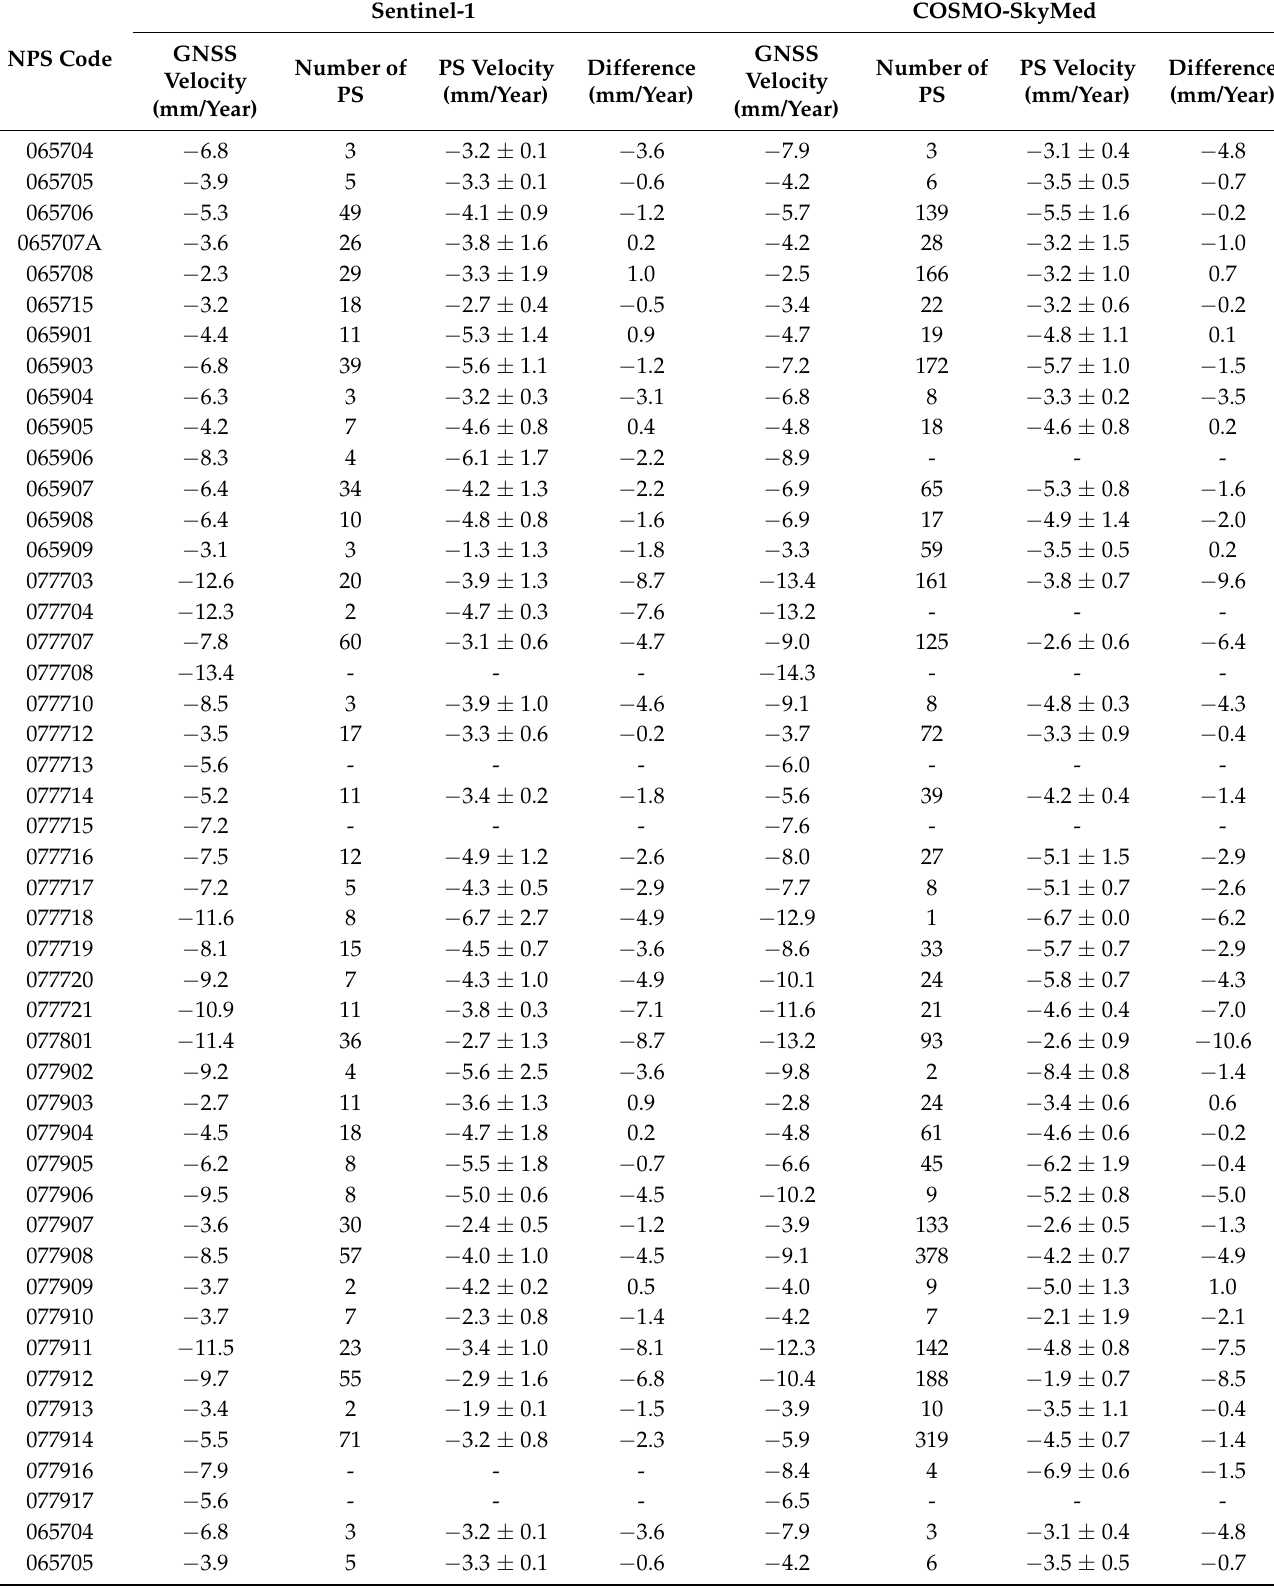
Table 3. Comparison between the LOS velocities of the PODELNET sites and the mean velocities of PS points within a circle centered on the NPS and with a radius of 200